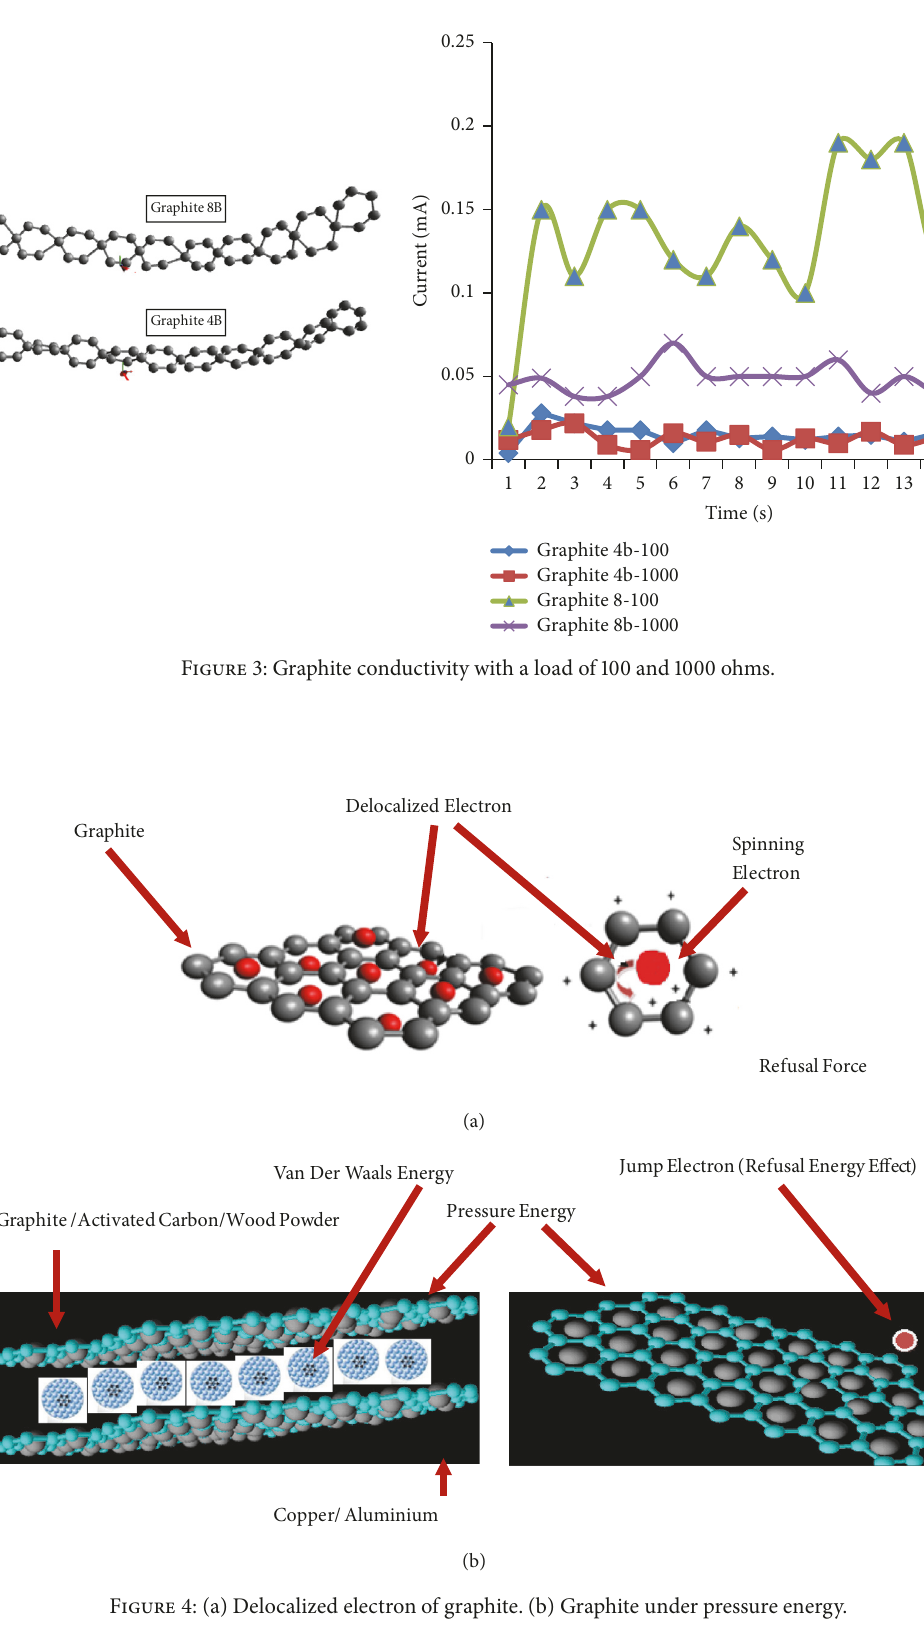
Figure 4: (a) Delocalized electron of graphite. (b) Graphite under pressure